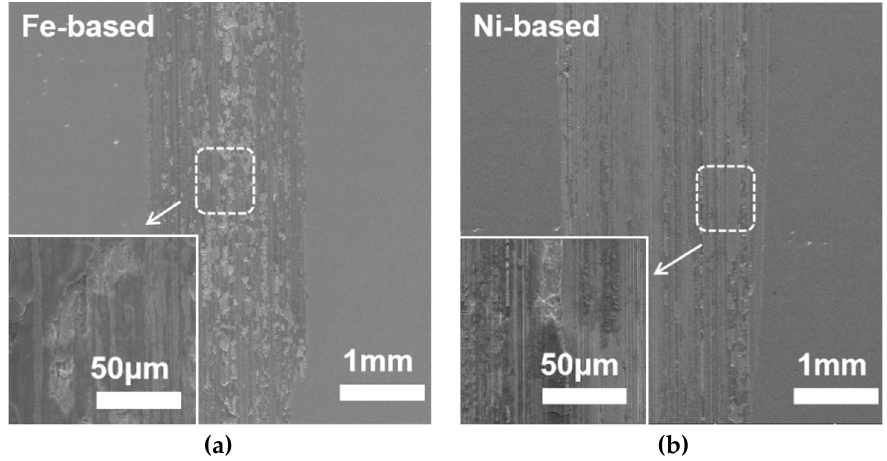
Figure 9. Fe-based and Ni-based substrate SEM images. ( a ) Wear marks of Fe-based substrate; ( b ) Wear marks of Ni-based substrate. Table 7. Substrate atoms for each element content